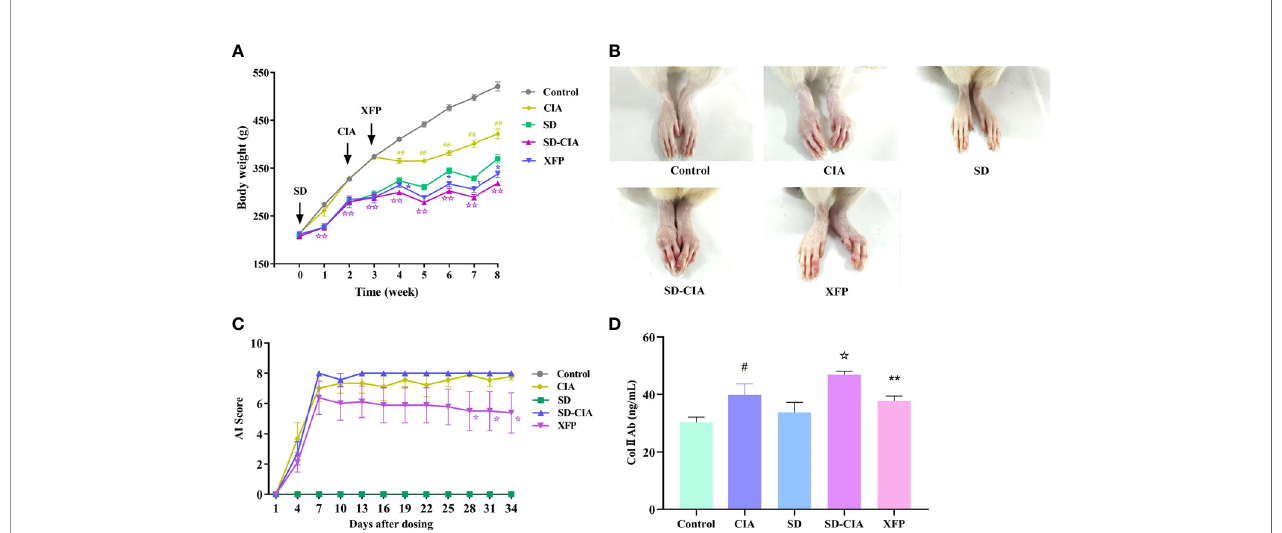
FIGURE 2 | Therapeutic effect of XFP on a rat model of SD-CIA. (A) Body weight of each group. Weight was measured once a week. (B) Representative gross images of the ankle joint of each group on day 34 after treatment. (C) The line graph of AI scores every 3 days. (D) The levels of Col II Ab in the serum of each group. n = 10 (control and SD), n = 8 (CIA and SD-CIA), n = 9 (XFP)8. Data are presented as the mean ± SEM . # P < 0.05 and ## P < 0.01 compared to the control group; ☆ P < 0.05 and ☆☆ P < 0.01 compared to the CIA group; *P < 0.05 and **P < 0.01 compared to the SD-CIA group. XFP, Xiong Fu powder; Col II Ab, anti – collagen type II antibody; SD-CIA, collagen-induced arthritis with spleen de fi ciency; AI, arthritis index; CIA, collagen-induced arthritis; SD, spleen de fi